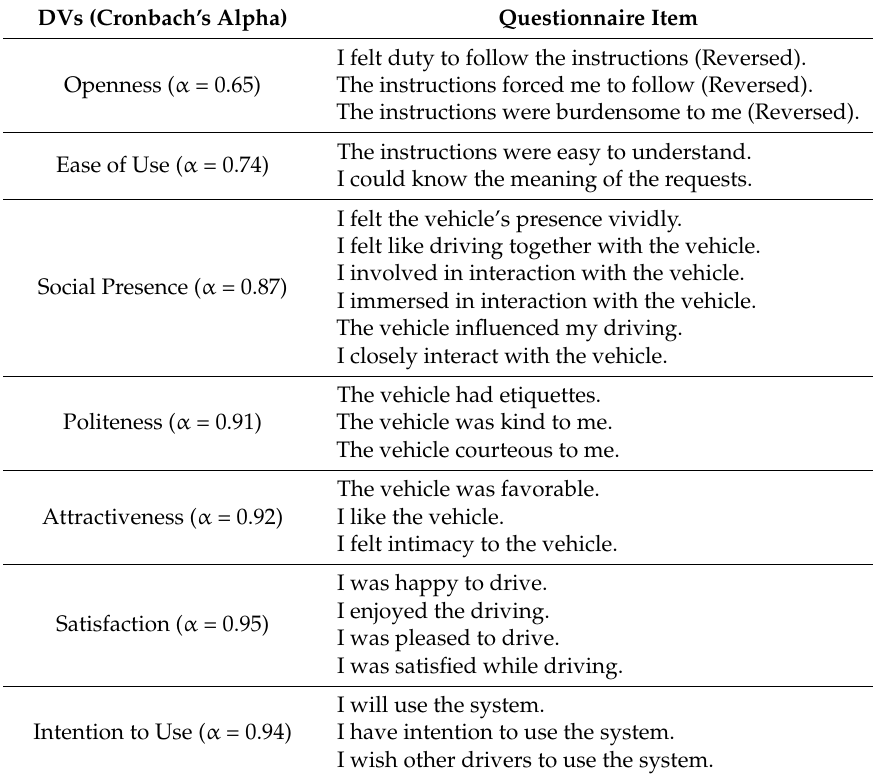
Table A1. Questionnaire of Cooperative Driving